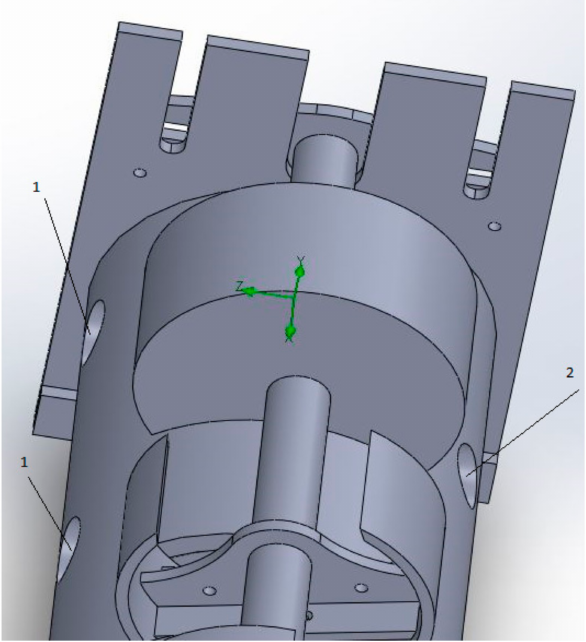
Figure 19. General view of the volume-sectional hydraulic